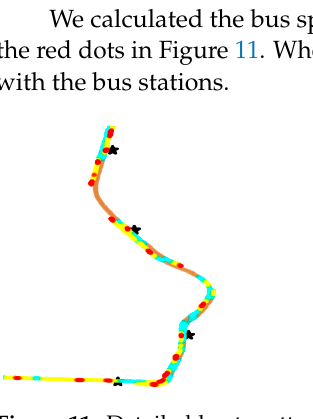
Figure 11. Detailed heat scatter plot of proper stopping at some bus stations (represented as “*”) with a low speed.